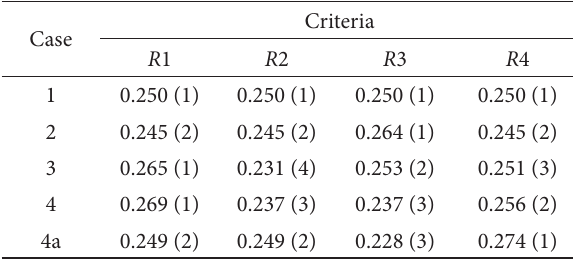
Table 3. The criteria importance calculation results for all cases (rank within a particular